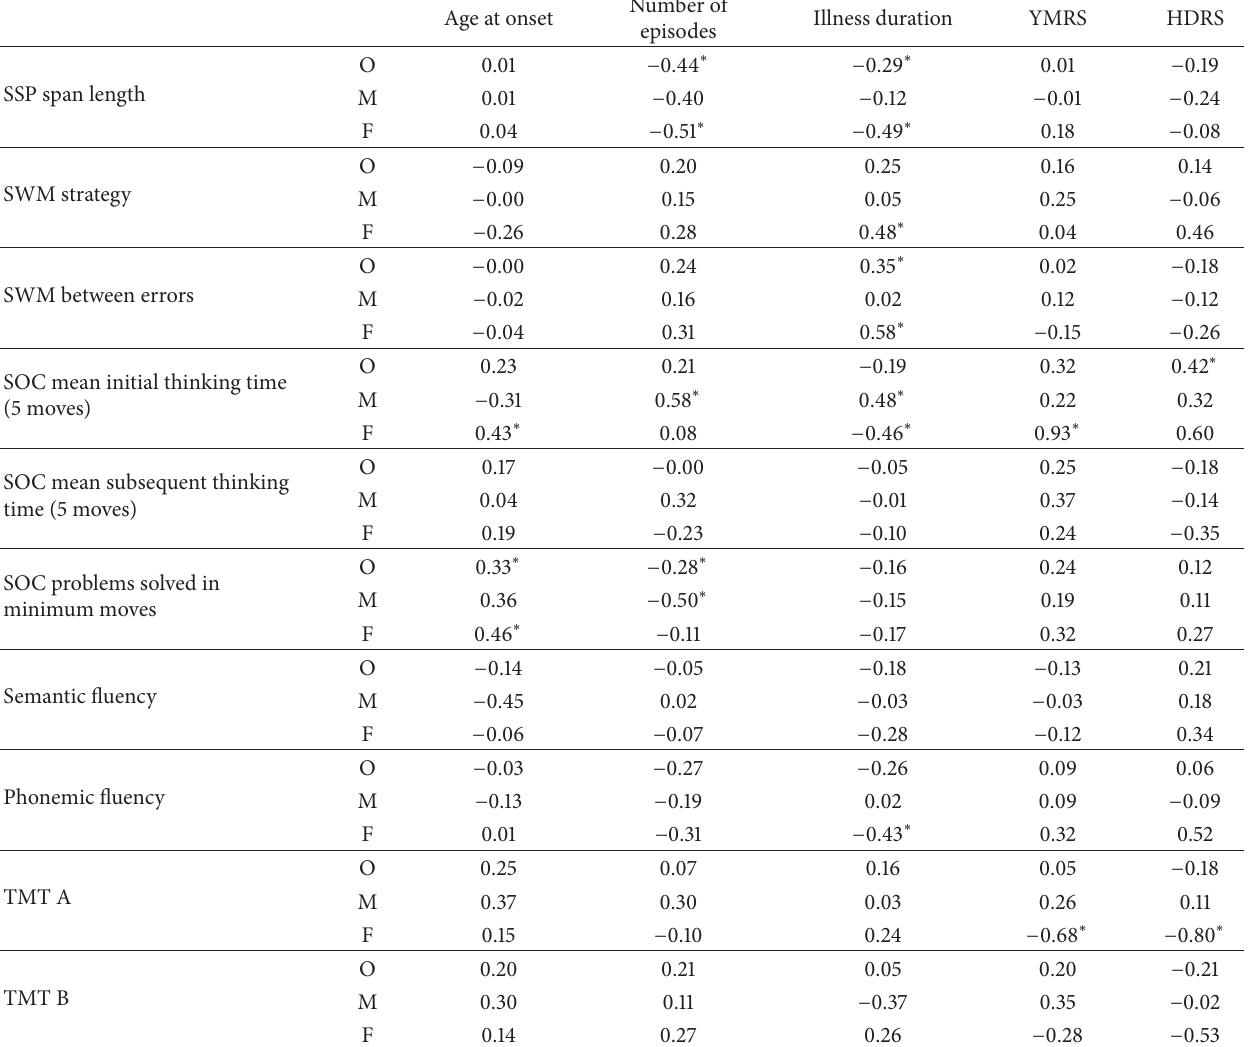
Table 5: Correlations between clinical factors and cognitive tests results ( ∗ significant at 𝑃 < 0.05 ) in bipolar